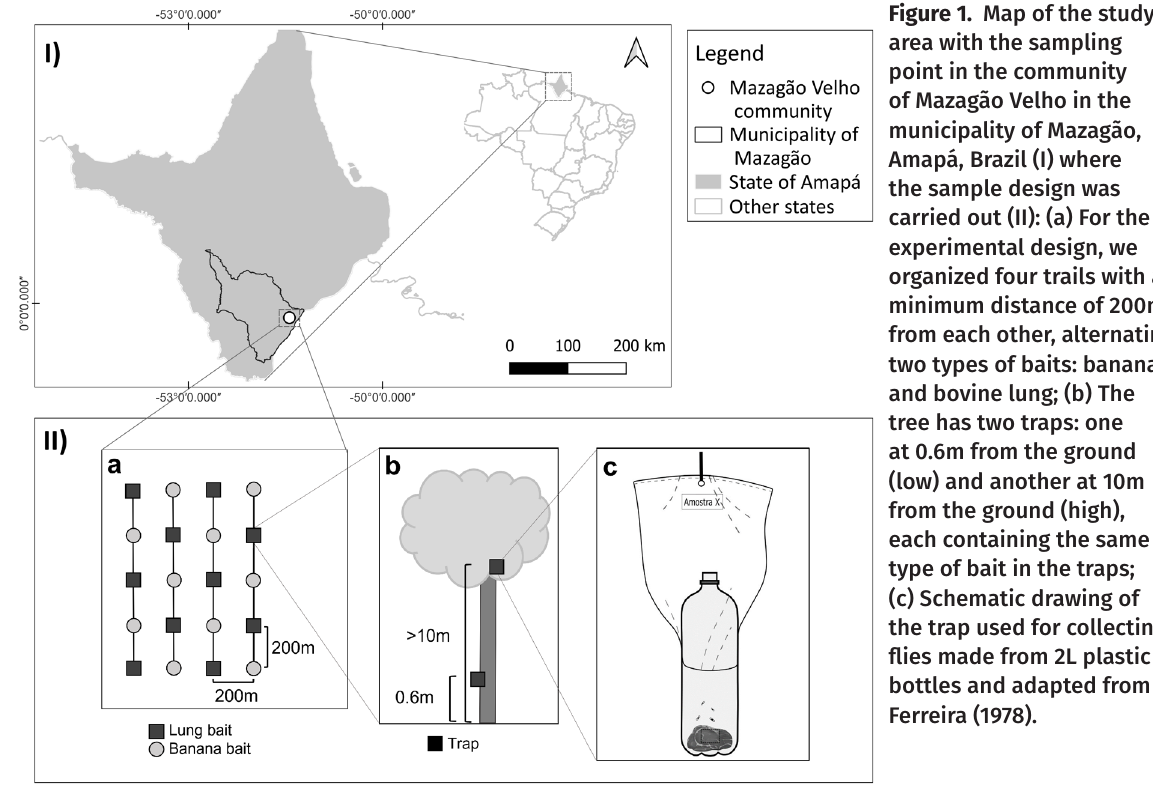
Figure 1. Map of the study area with the sampling point in the community of Mazagão Velho in the municipality of Mazagão, Amapá, Brazil (I) where the sample design was carried out (II): (a) For the experimental design, we organized four trails with a minimum distance of 200m from each other, alternating two types of baits: banana and bovine lung; (b) The tree has two traps: one at 0.6m from the ground (low) and another at 10m from the ground (high), each containing the same type of bait in the traps; (c) Schematic drawing of the trap used for collecting flies made from 2L plastic bottles and adapted from Ferreira